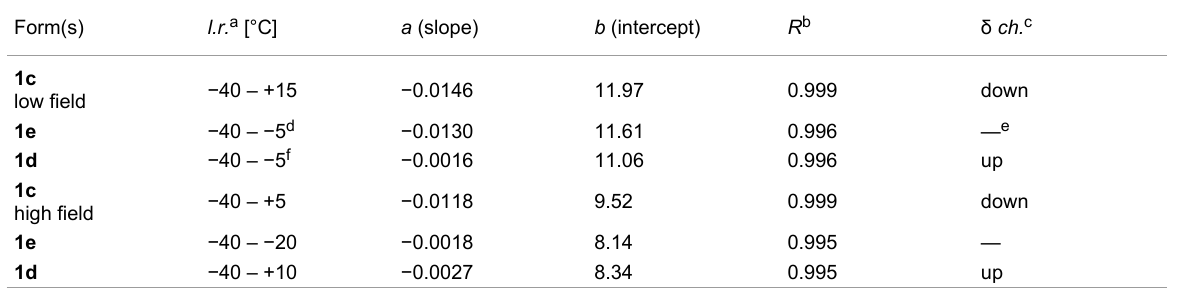
Table 2: The linear fitting of the δ [ppm] = f (T) function for benzoates. Form(s)